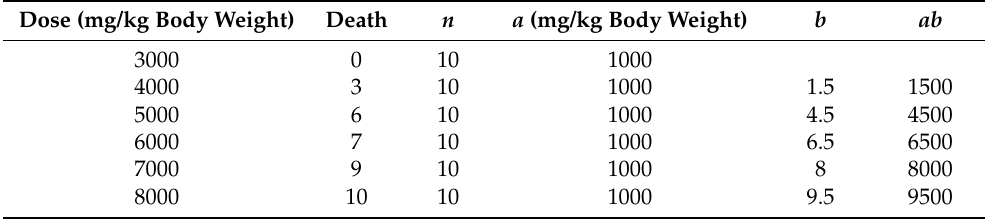
Table 1. Test data for determination of LD 50 values for penicillin IVa ( n —number of mice in each group, a —difference between two consecutive doses, and b —average value of the deaths from two consecutive